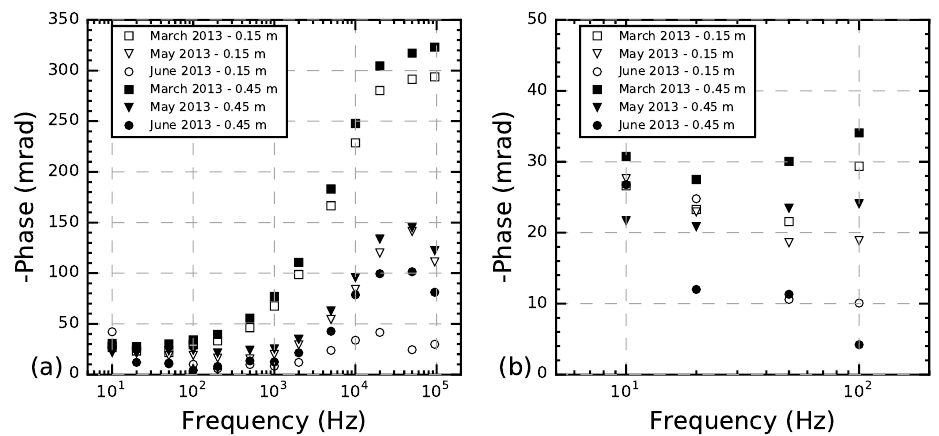
Figure 10. Phase of complex conductivity measured in 2013 as a function of frequency: (a) from 0Hz to 95kHz; (b) from 0 to